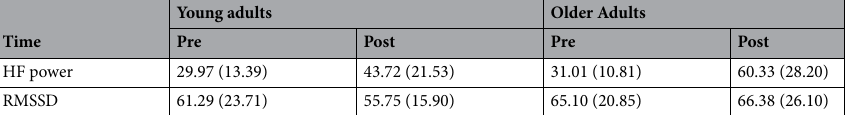
Table 2. Mean (SD) for HF power and RMSSD across the young and older adult groups in the pre- and post-